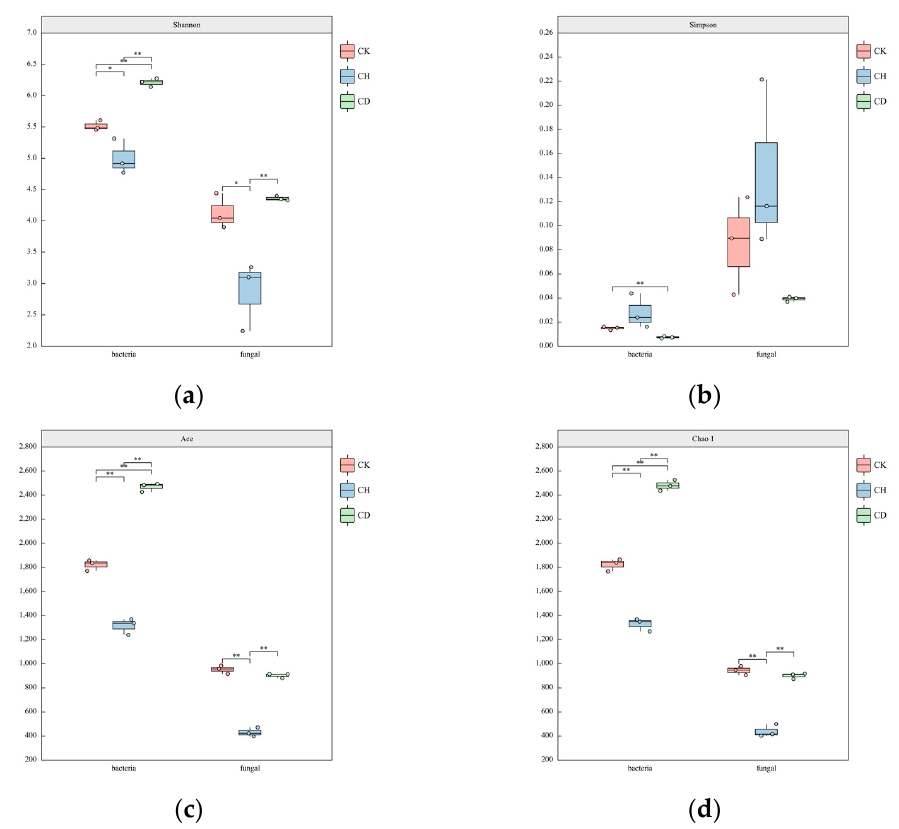
Figure 7. Boxplots of the alpha diversity of bacteria and fungi in the rhizosphere soil of the three samples. ( a ) Shannon index of bacteria and fungi in the rhizosphere of the three samples. ( b ) Simpson index of bacteria and fungi in the rhizosphere of the three samples. ( c ) ACE index of bacteria and fungi in the rhizosphere of the three samples. ( d ) Chao 1 index of bacteria and fungi in the rhizosphere of the three samples. CH—biennial ginseng seedlings that were transplanted and then continuously cropped for four years in healthy ginseng rhizosphere woodland soil, CD—biennial ginseng seedlings that were transplanted and then continuously cropped for four years with severe soilborne disease in ginseng rhizosphere woodland soil, CK—soil sample from woodland without ginseng planting; * represents a significant correlation ( p < 0.05), whereas ** represents an extremely significant correlation ( p < 0.01).